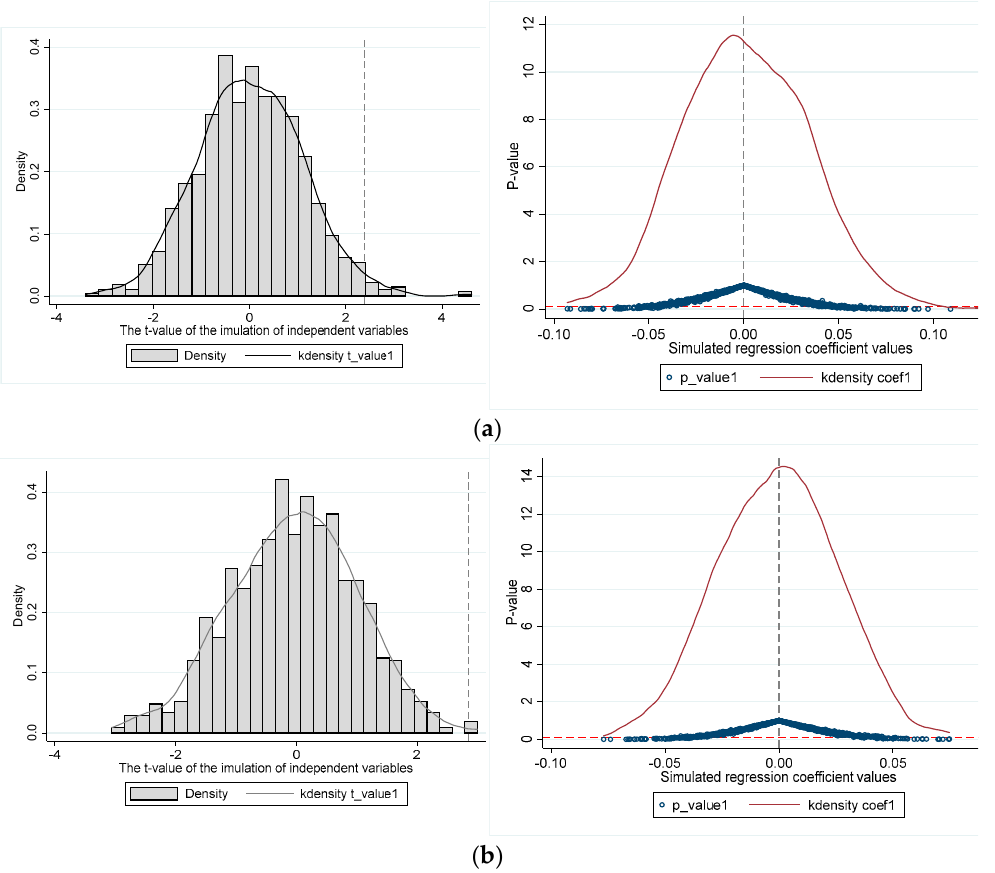
Figure 3. Distribution of estimated coefficients and t -values of falsification test. ( a ) The grain sown area, ( b ) The Total Grain Production. Note: The figure shows the cumulative distribution density of the estimated coe ffi cients from 1000 simulations randomly assigning the pilot status to counties.